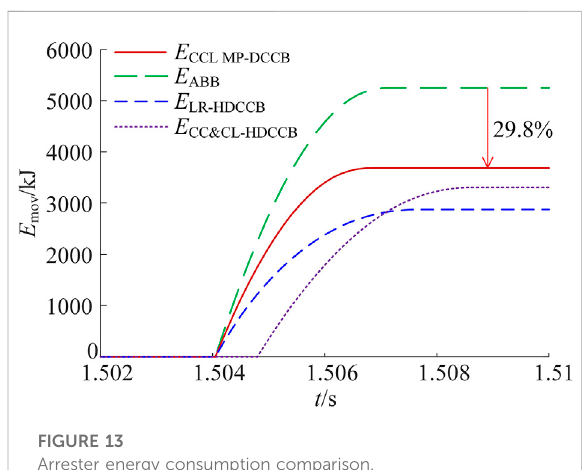
FIGURE 13 Arrester energy consumption comparison.